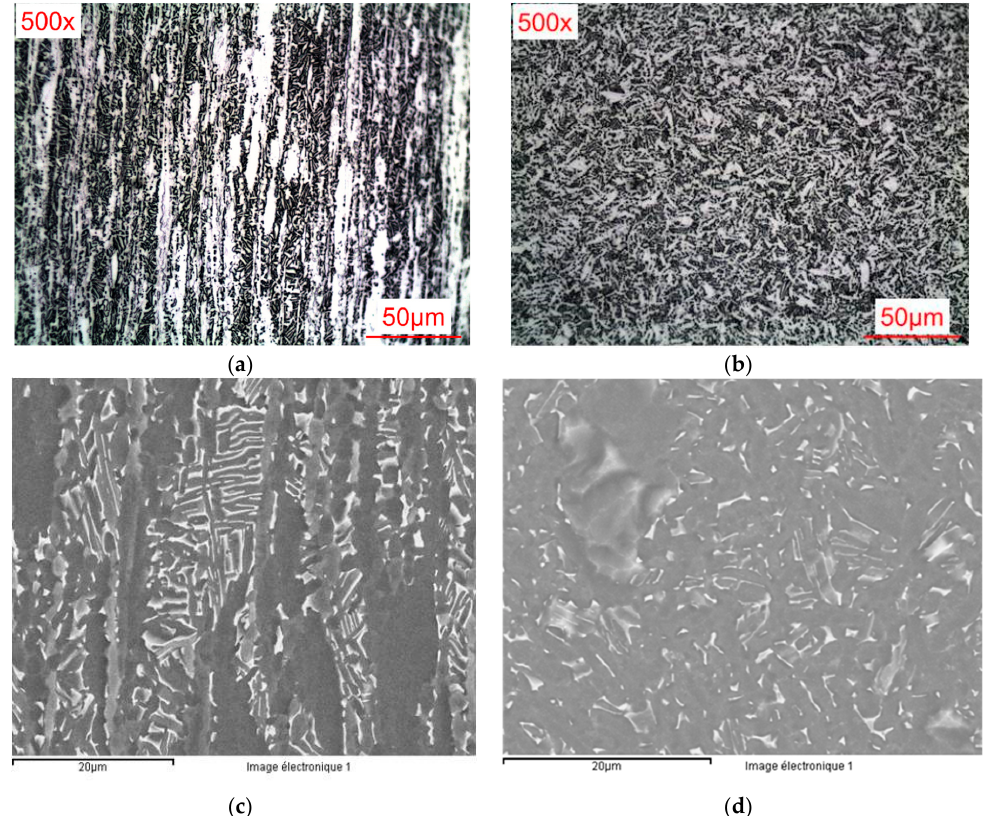
Figure 7. Alloy microstructure (#1): longitudinal section ( a ) optical microscopy (OM) and ( b ) scanning electron microscope (SEM) images; transversal section ( c ) OM and ( d ) SEM